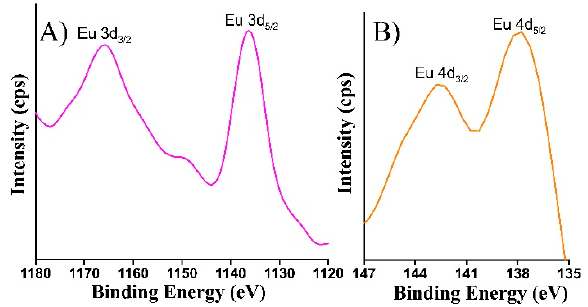
Figure 6. Narrow scan XPS spectra of ( A ) Eu 3d and ( B ) Eu 4d region in Eu-doped TiOx thin film.